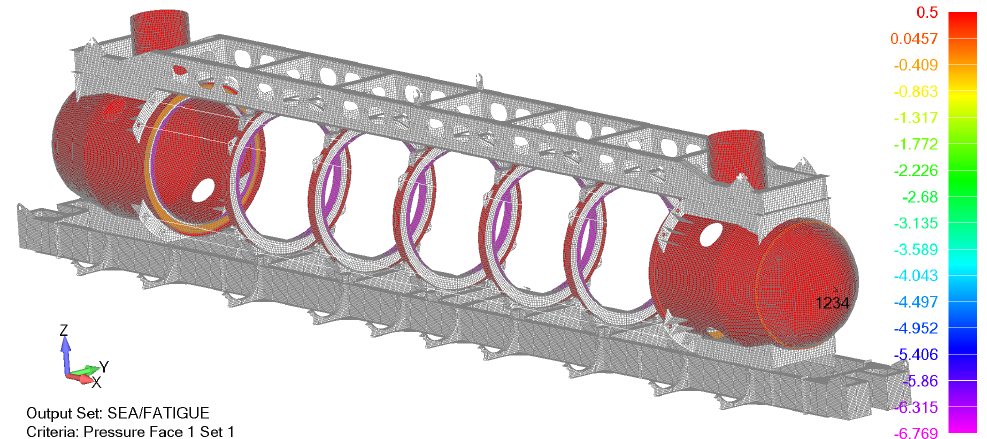
Figure 10. Loads and boundary conditions for fatigue analysis (pressure in MPa).